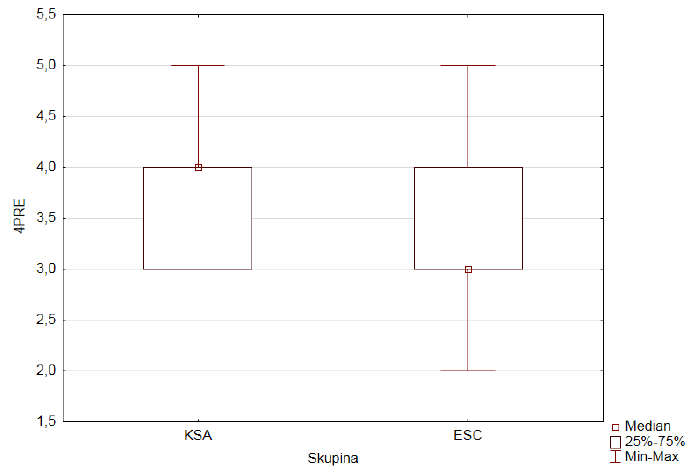
Figure 11. The box graph of the fourth item of the pretest - 4PRE.